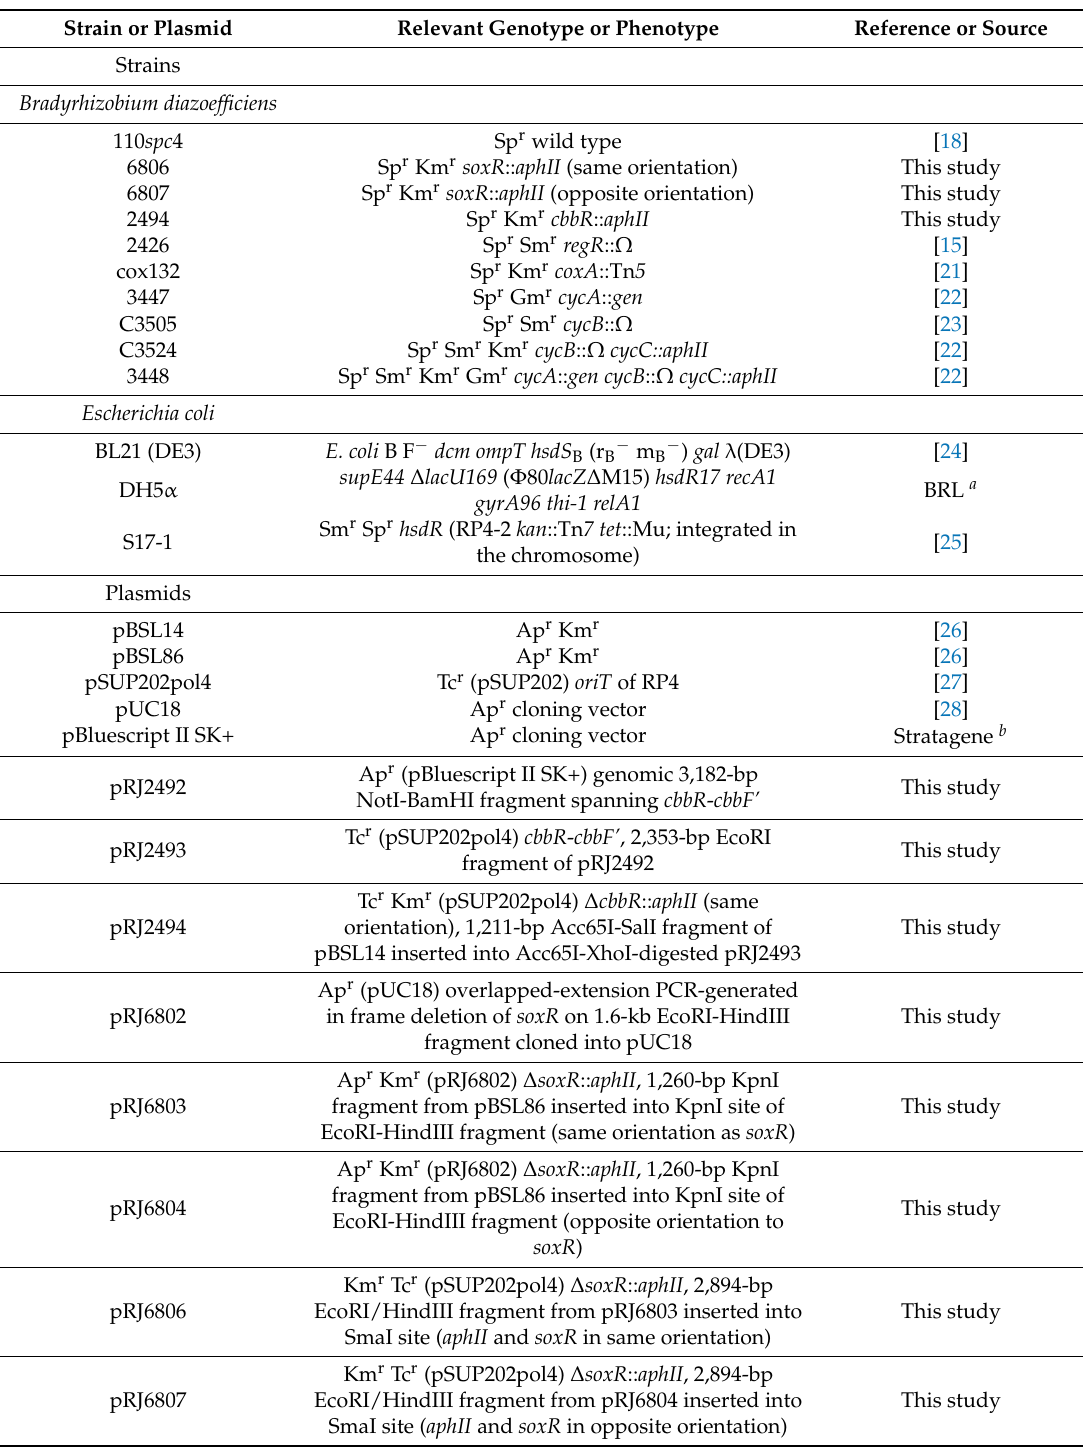
Table 1. Bacterial strains and plasmids used in this